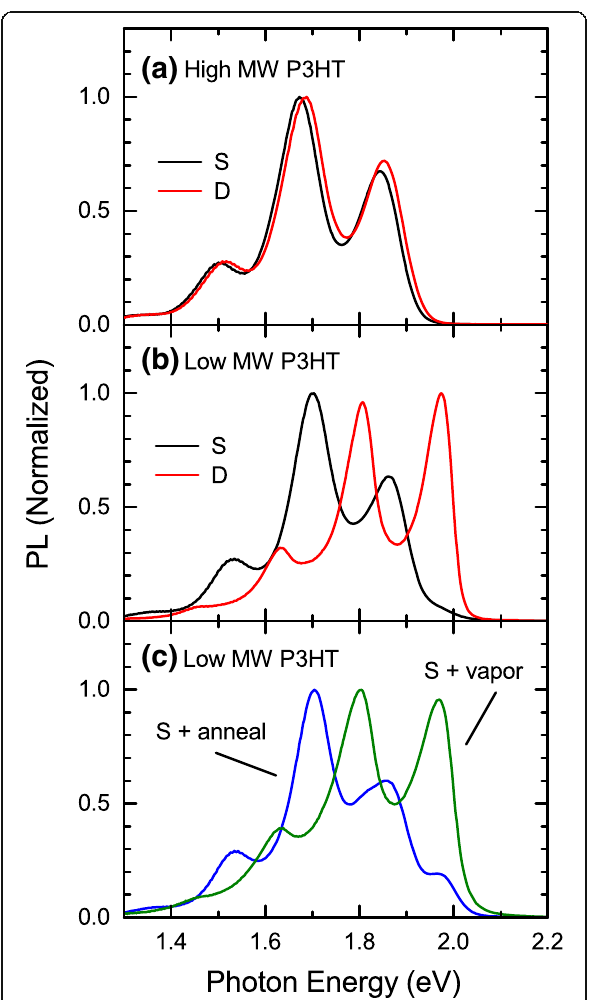
Fig. 3 Normalized PL spectra of a high and b , c low MW P3HTs at 6 K. S and D mean the samples prepared by spin-coating and drop-casting,